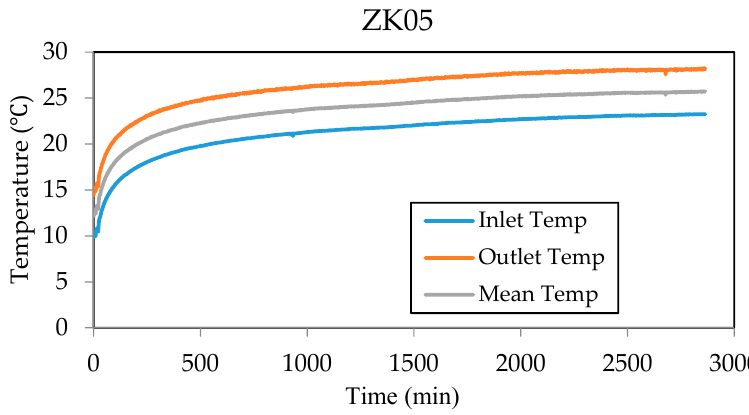
Figure 15. Inlet and outlet fluid temperatures during the test.